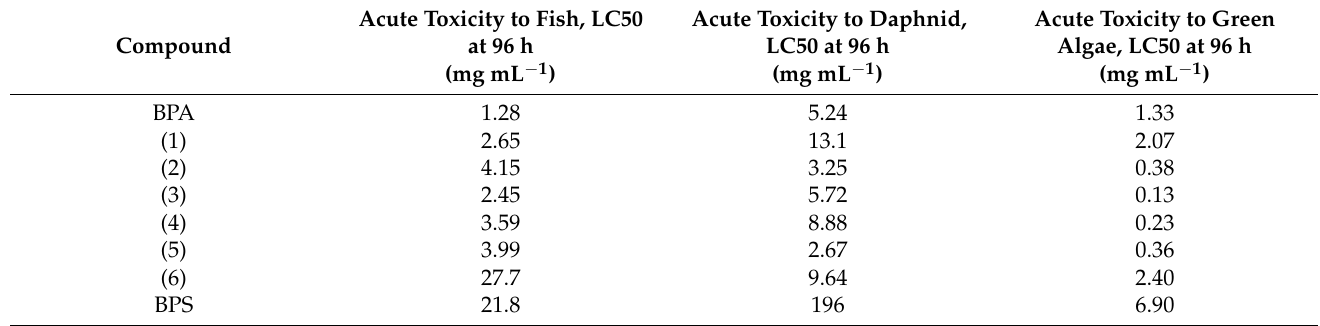
Table 1. Acute toxicity of bisphenols and their degradation products to fish, daphnid, and green algae.